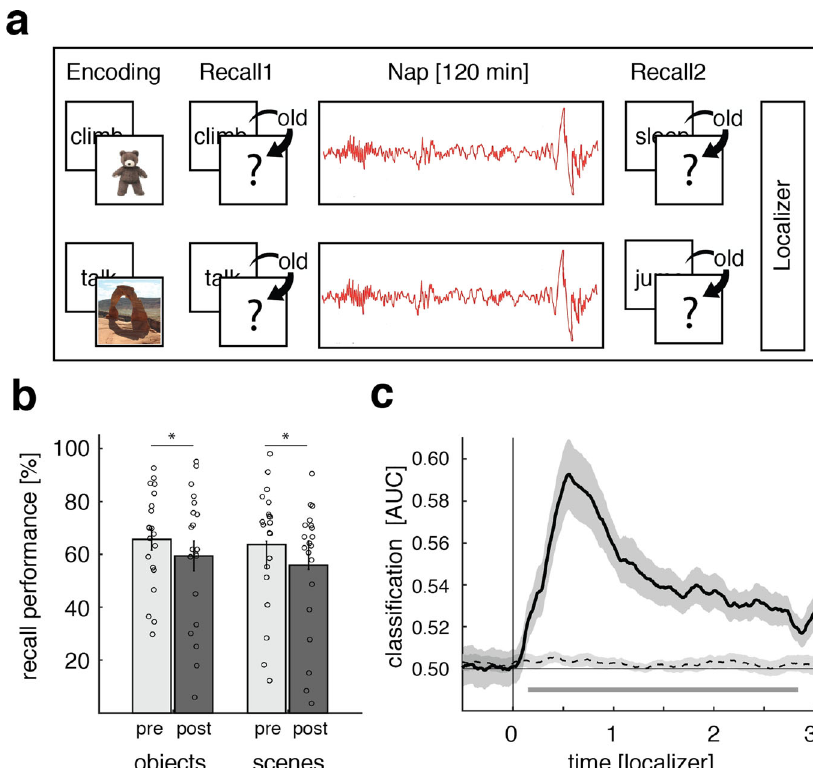
Fig. 1 Experimental procedure, behavioral results, and localizer task. a During encoding, participants were presented with 120 verb-object or verb-scene combinations (depending on experimental session). Memory performance was tested before and after a 120 min nap period. At the end of each session, participants performed a localizer task in which they processed a new set of object and scene images. b Behavioral results for both experimental sessions pre- (light gray) and post-sleep (dark gray). Bar graphs show mean (±SEM) percentage of recalled image exemplars out of correctly recognized verbs. Dots indicate individual memory performance of participants ( N = 20). Stars denote signi fi cant differences as derived from a repeated measures ANOVA ( p = 0.001). c Stimulus categories (objects vs. scenes) could be reliably decoded (above chance) from the localizer EEG data, starting around 150 ms post stimulus onset (the black solid line indicates decoding performance (±SEM)). The horizontal dashed line indicates surrogate decoding performance, which was estimated by shuf fl ing the training labels 250 times. The vertical solid line indicates stimulus onset (time = 0). The lower horizontal gray line shows the temporal extent of signi fi cant decoding results as derived from a dependent-samples t -test (two-sided, p = 0.002, cluster corrected across time). Source data are provided as a Source Data fi